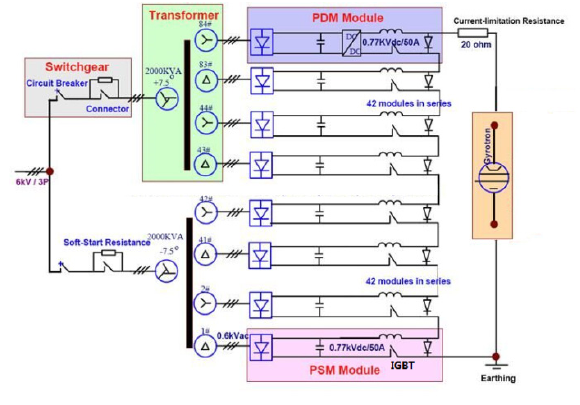
Fig. 3. The architecture of the cathode high voltage power supply.